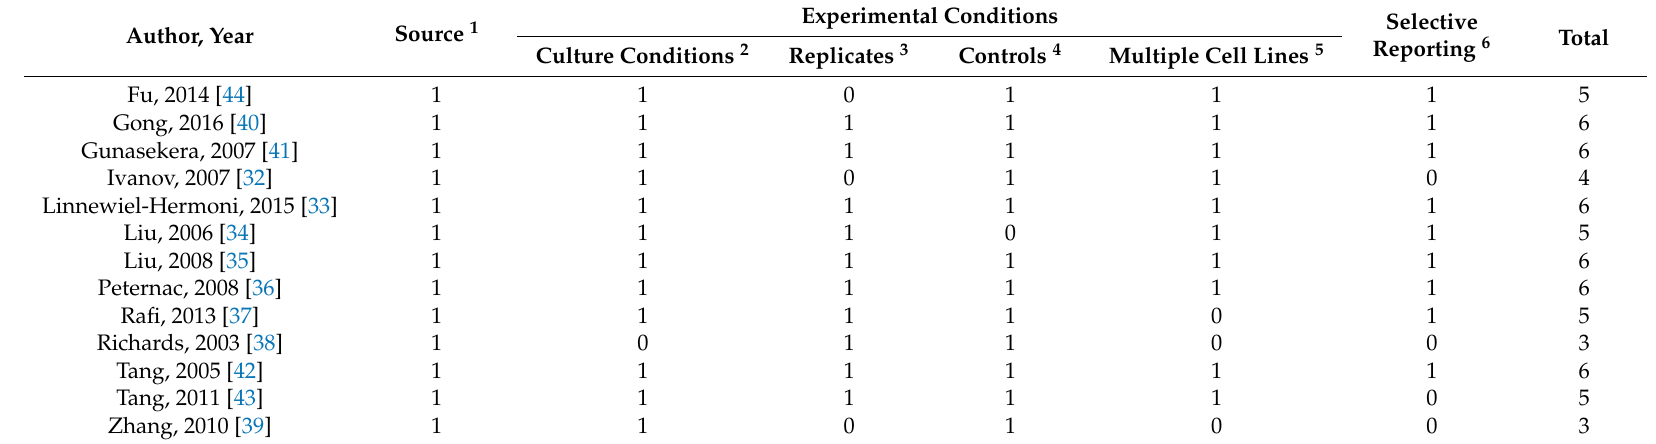
Table A2. Quality assessment of included cell culture studies (adapted from WCRF/UoB recommendations)